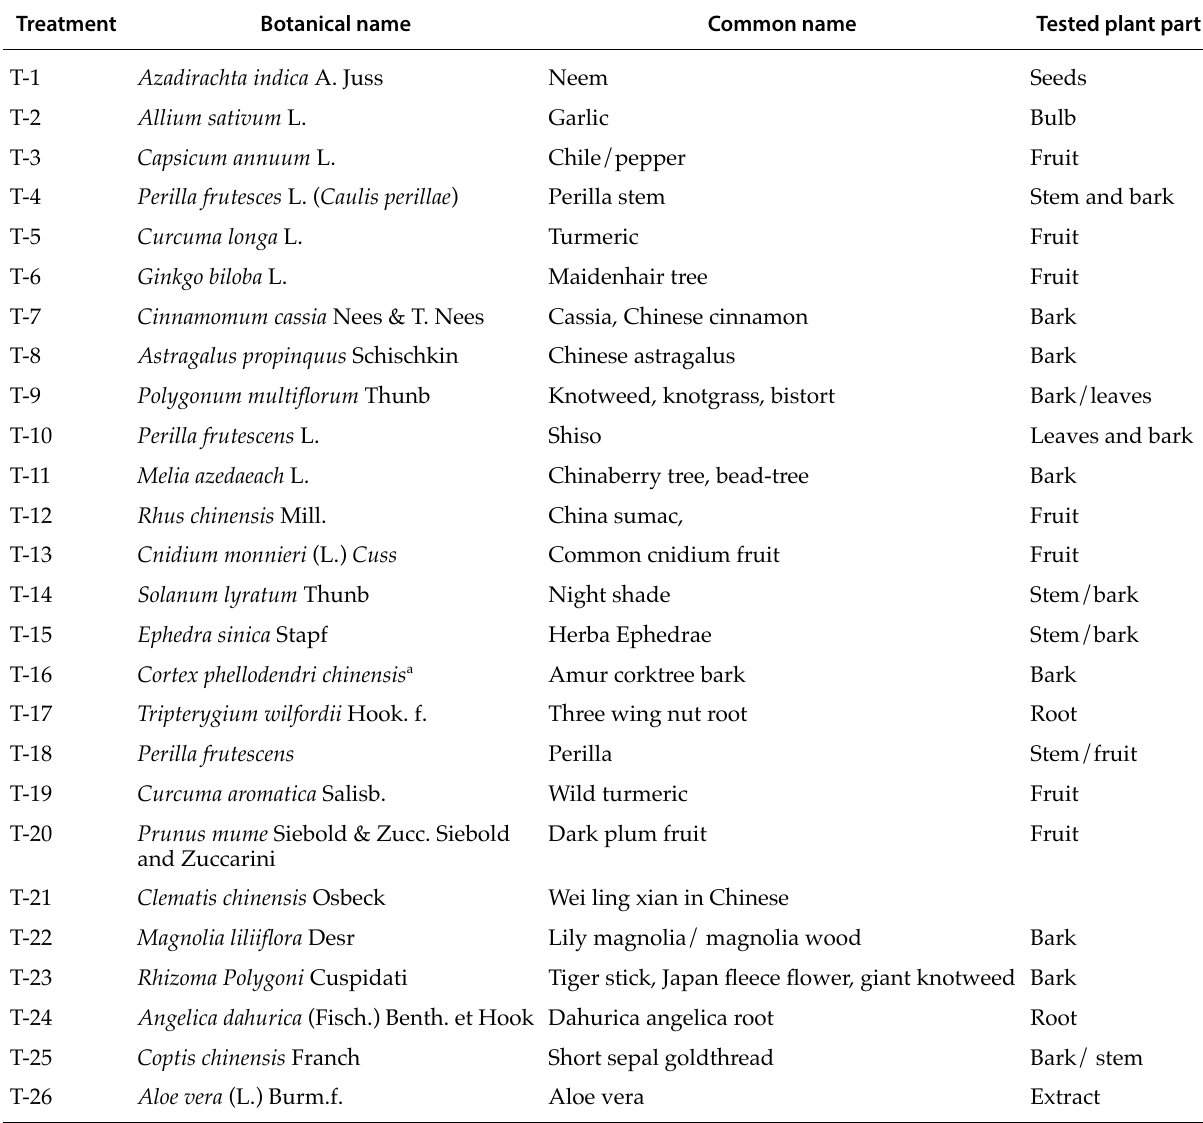
Table 1. List of the Chinese medicinal herbs used in this study. Treatment Botanical